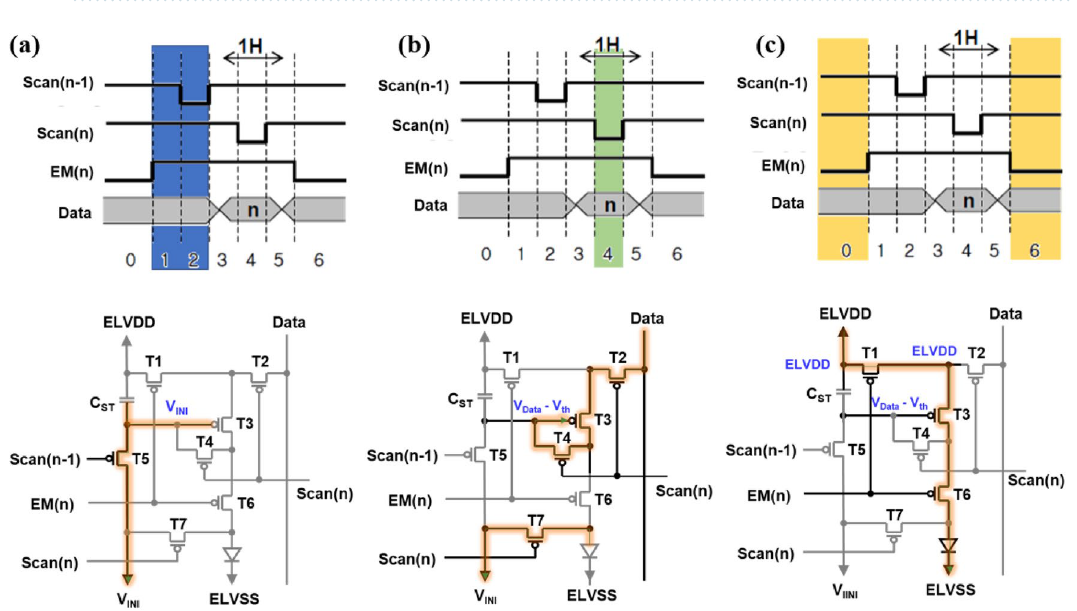
Figure 3. Driving sequence of 7T1C compensation pixels: ( a ) initialization step, ( b ) sampling step, ( c ) emission